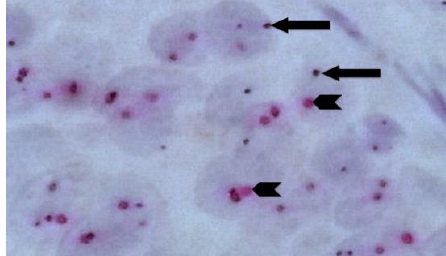
Fig. 6. Invasive Ductal Carcinoma With Non- Amplified HER2 Gene by the Silver DNA in Situ Hybridization Technique; HER2 gene black SISH intranuclear signals (arrows) typically appear smaller than chromosome 17 red ISH intranuclear signals (arrow heads) with an overall ratio of (black SISH signals/red ISH signals) < 2 (60X).